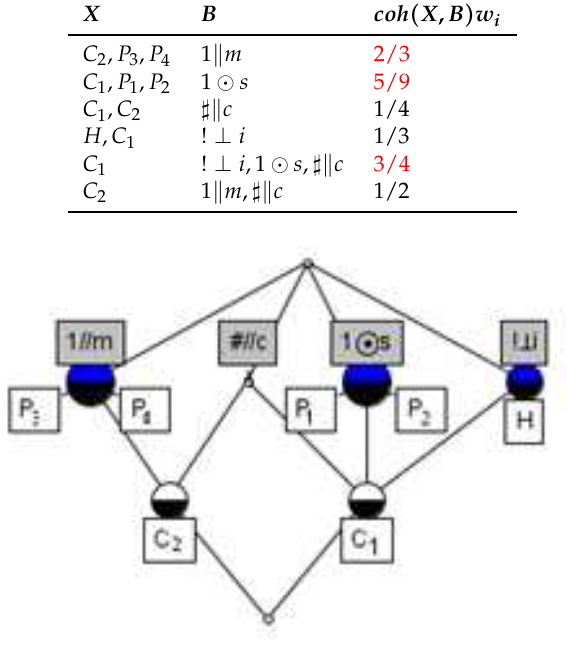
Figure 12. The concept lattice of Table 7. Table 11. The Coh value of a tray.